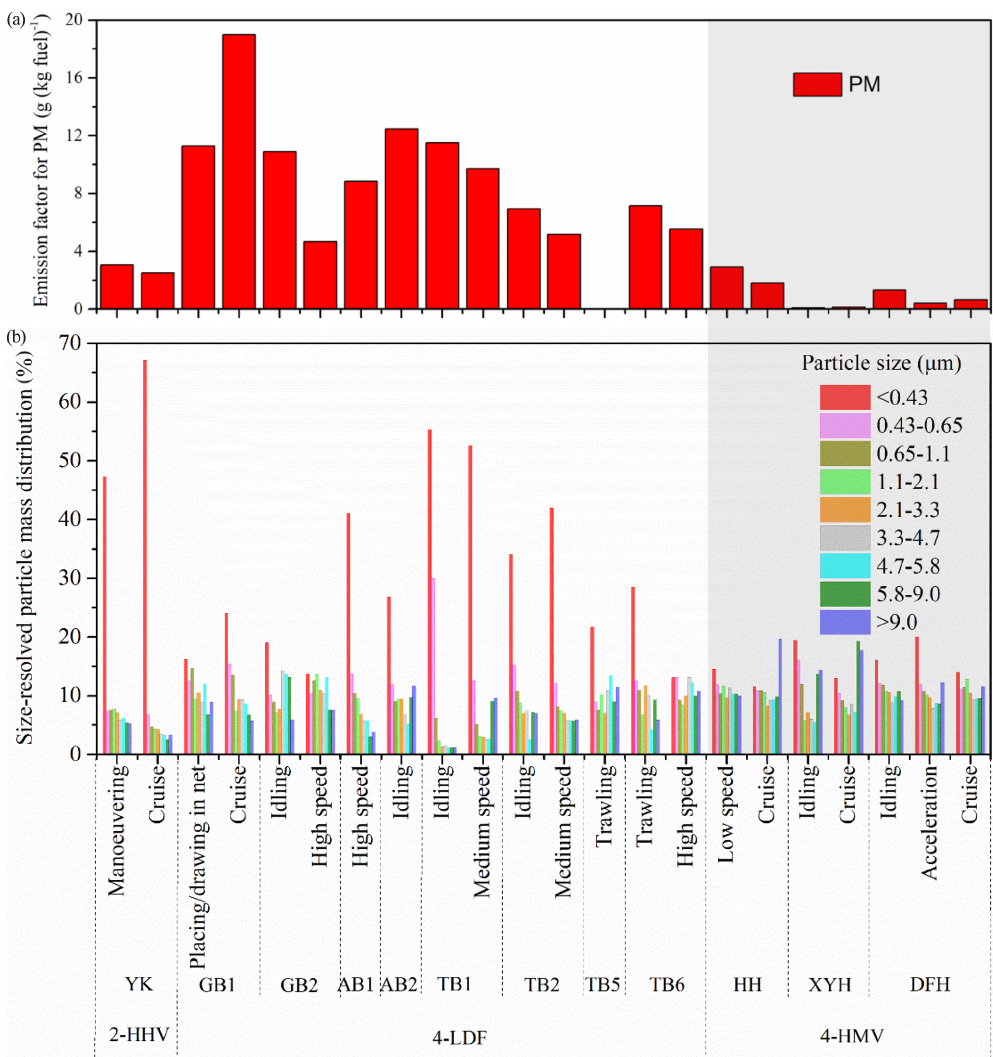
Figure 1. Emission factor for total PM and size-resolved particle mass distributions with different modes for the 12 tested ships (the vessels on the right in light gray used the undiluted system, and the rest of the vessels used the diluted